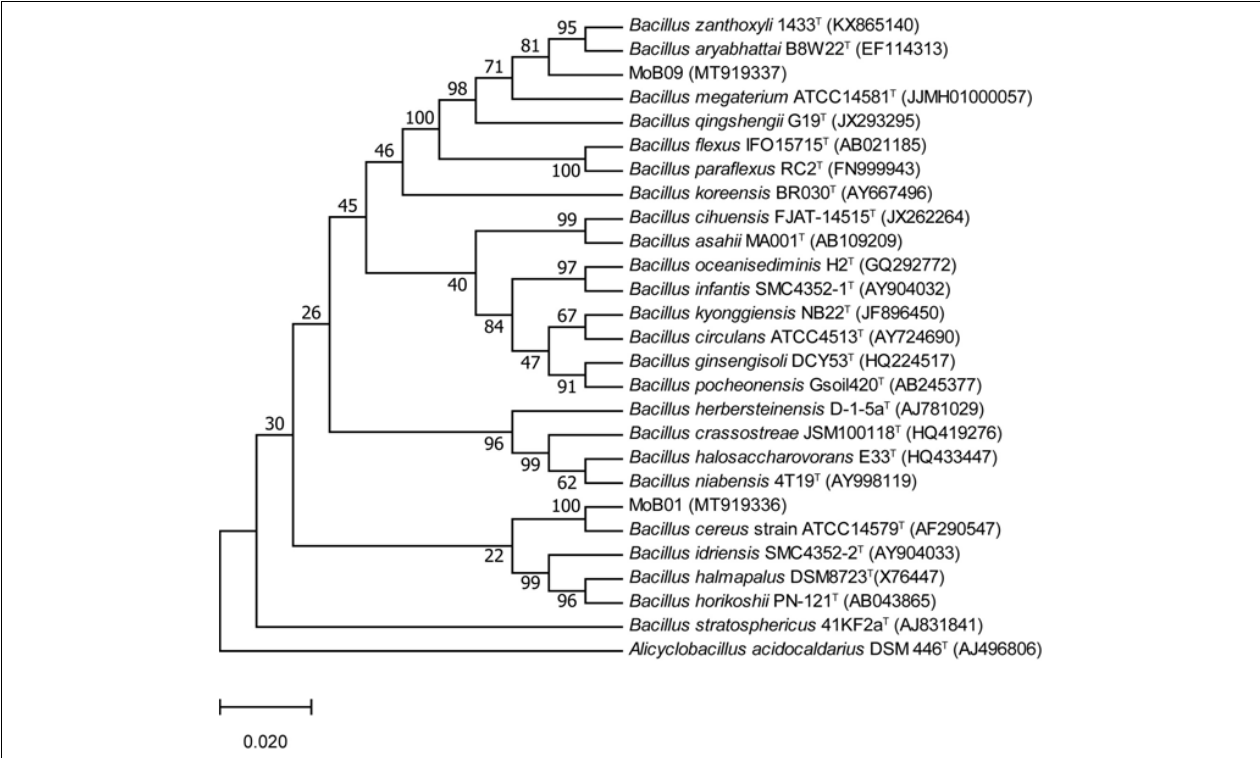
FIGURE 3 | Phylogenetic tree of strains MoB01 and MoB09 with closely related Bacillus -type species based on 16S rRNA gene sequences, constructed using the neighbor-joining method. Bootstrap values (expressed as percentages of 1,000 replications) of above 50%.